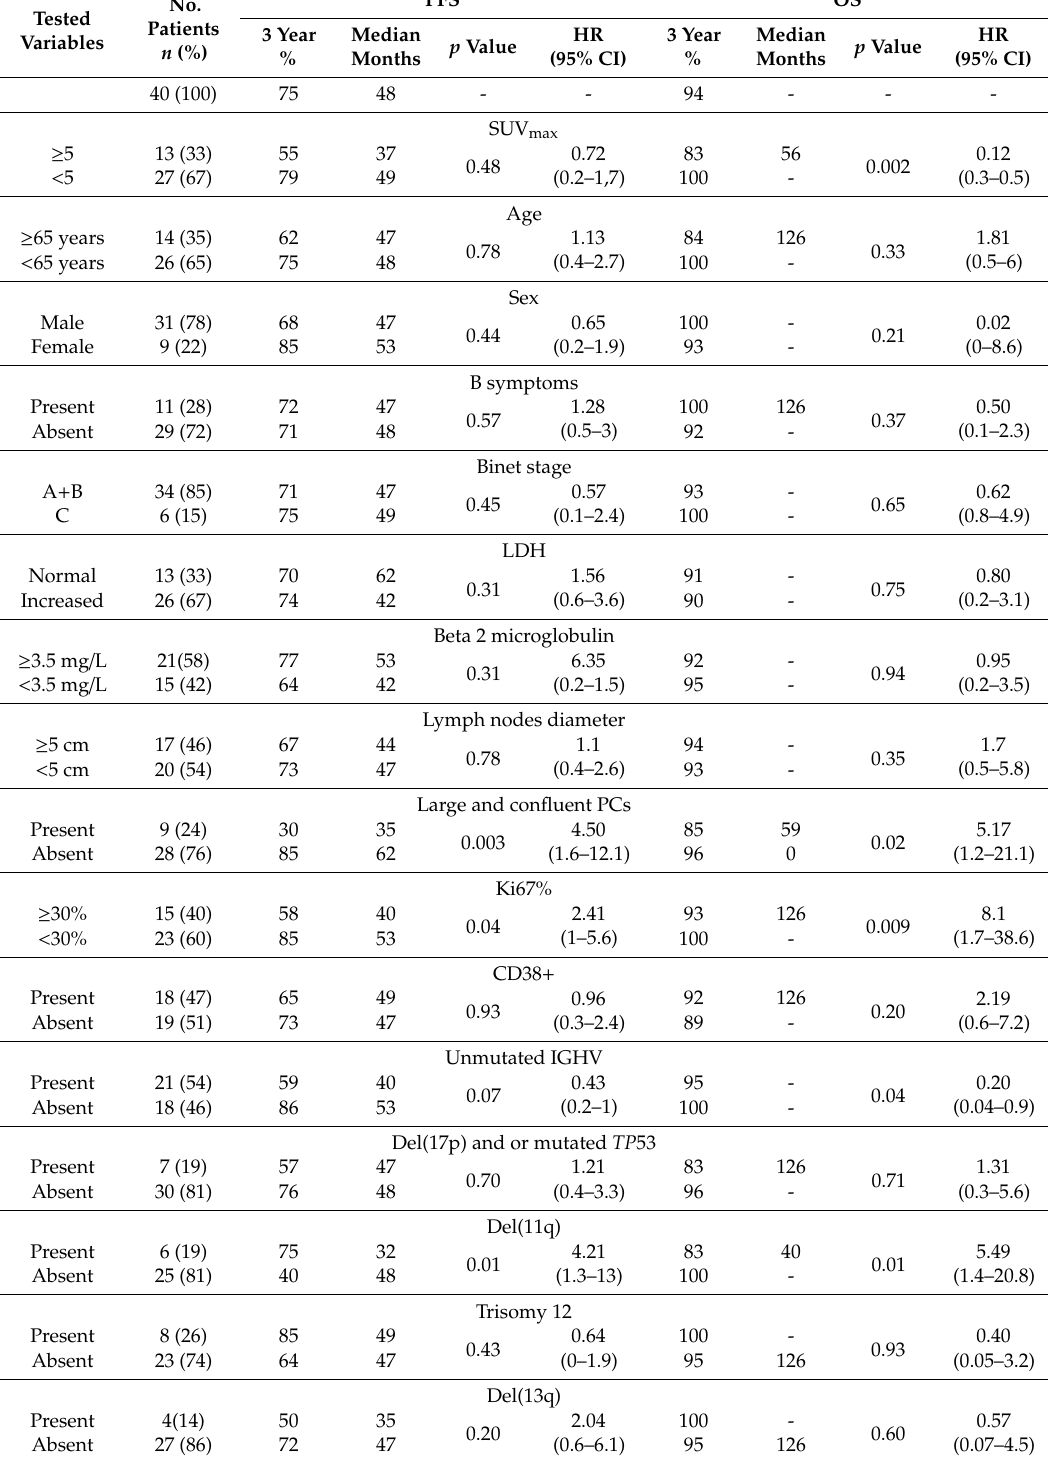
Table 2. PFS and OS according to the baseline characteristics of the patients: univariate analysis. Tested